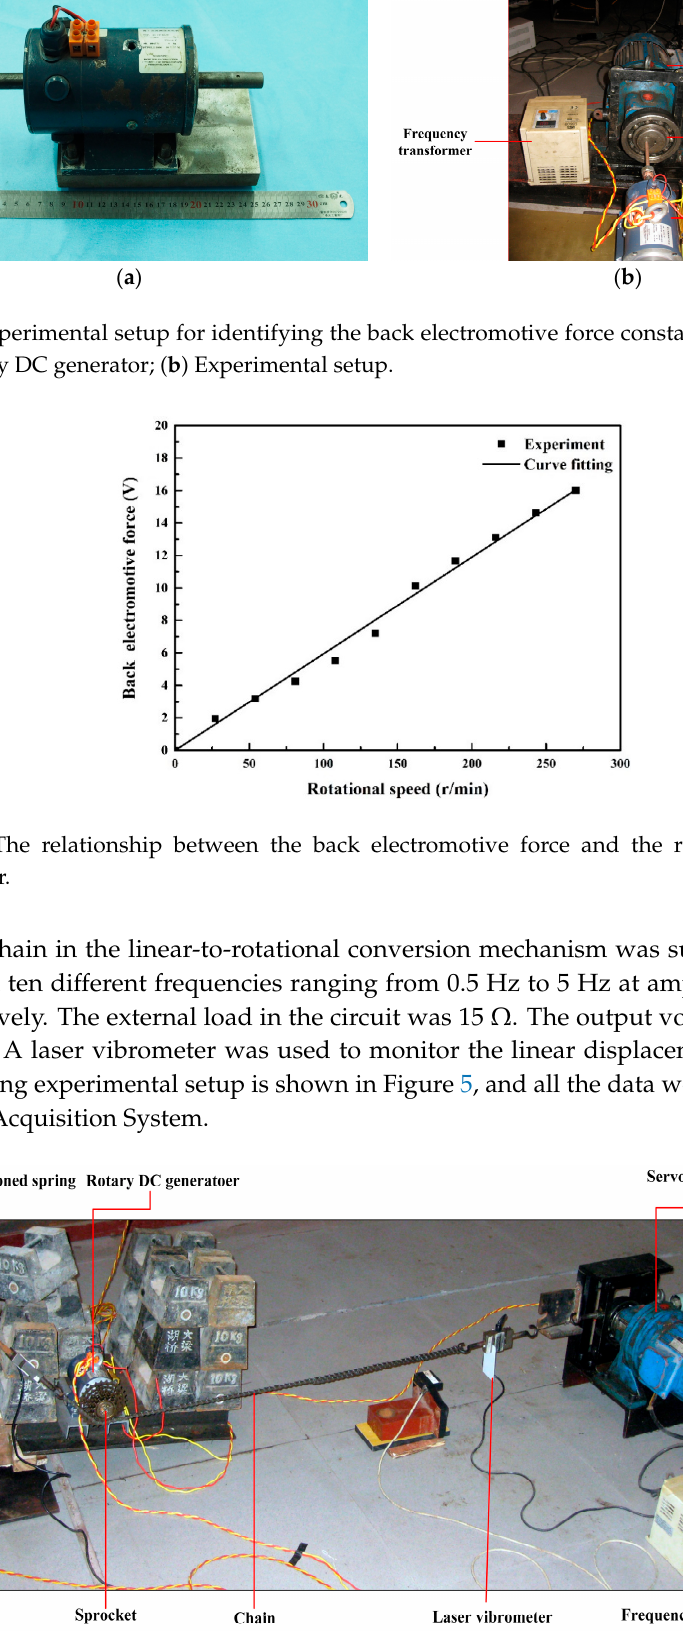
Figure 5. Experimental setup for the energy harvesting capability of the generator.